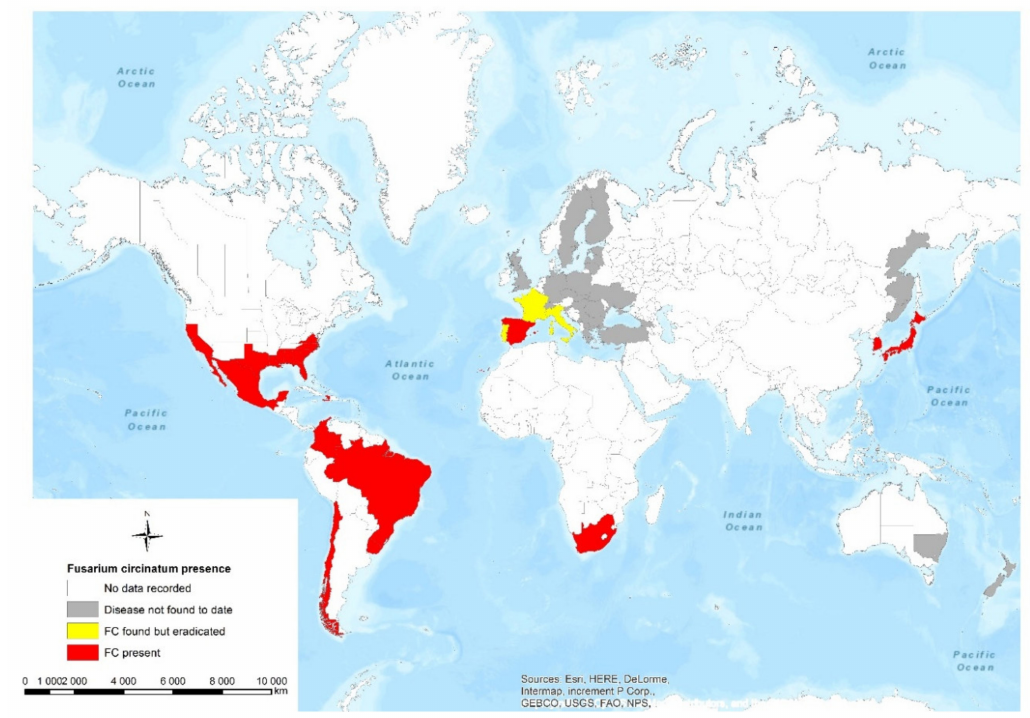
Figure 2. Global distribution of Fusarium circinatum showing where the pathogen is present, eradicated, not found or data are not available. See the interactive map: http: // bit.do / phytoportal for detailed locations within